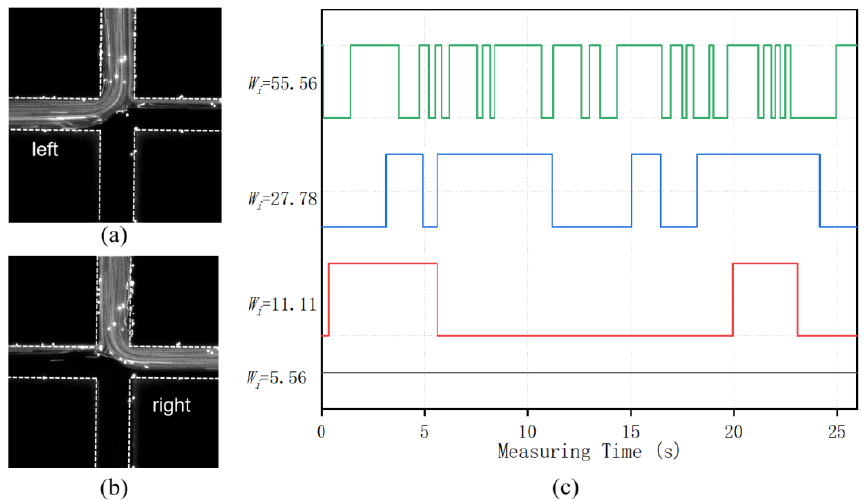
Figure 5. PAM flow pattern in the SCM at ( a , b ) two different instance at Wi = 11.11. ( c ) The flow bias direction in real time for PAM flow at different Wi